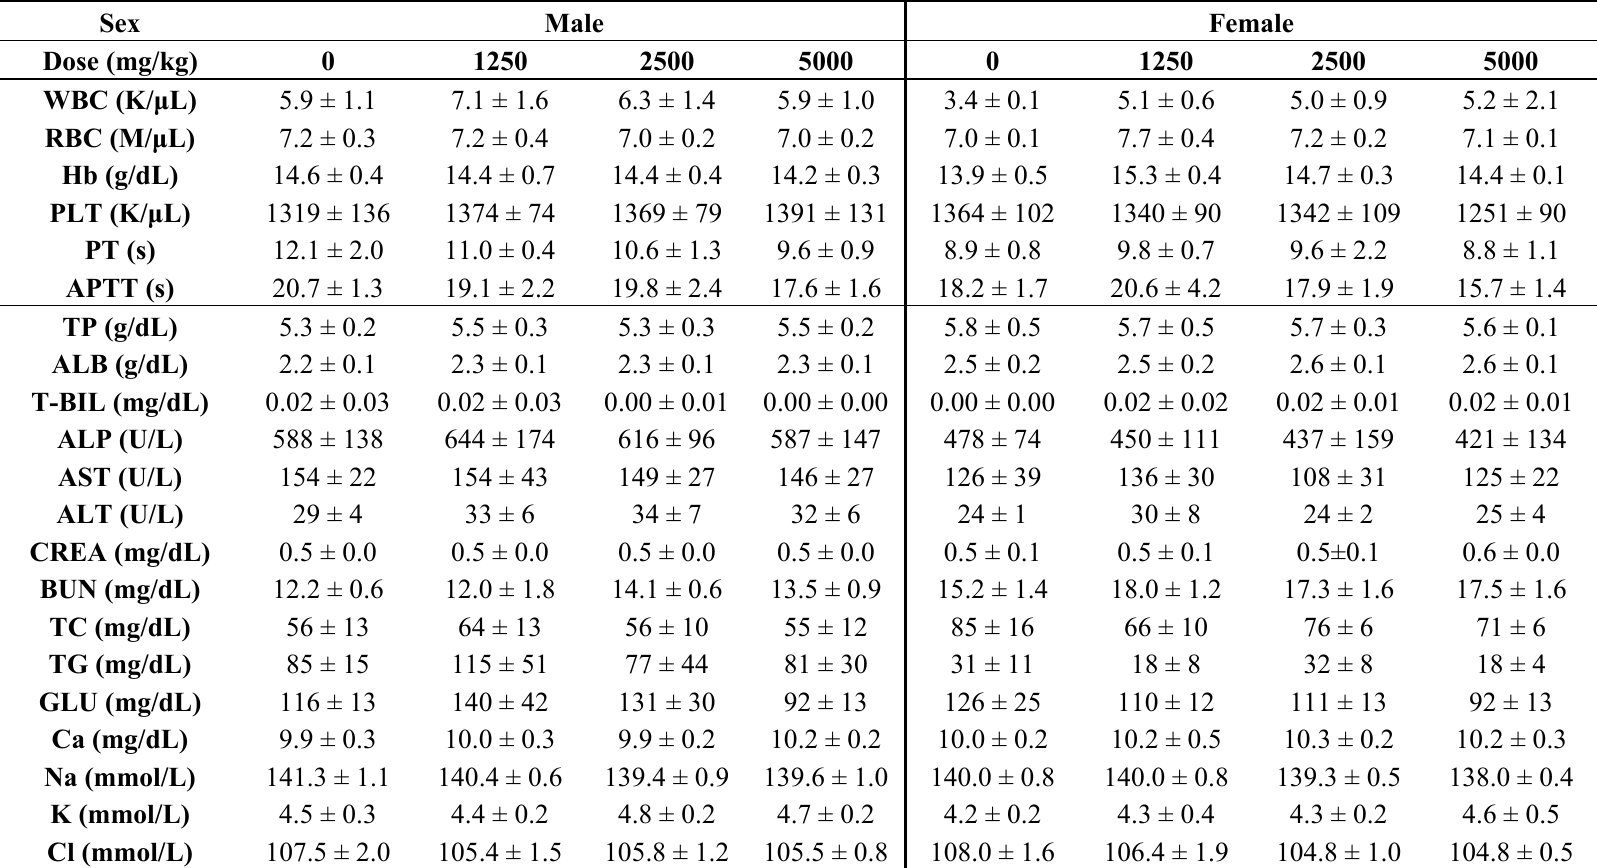
Table 5. Hematological results and serum biochemical data of male and female SD rats treated orally with C. setidens for 4 weeks.